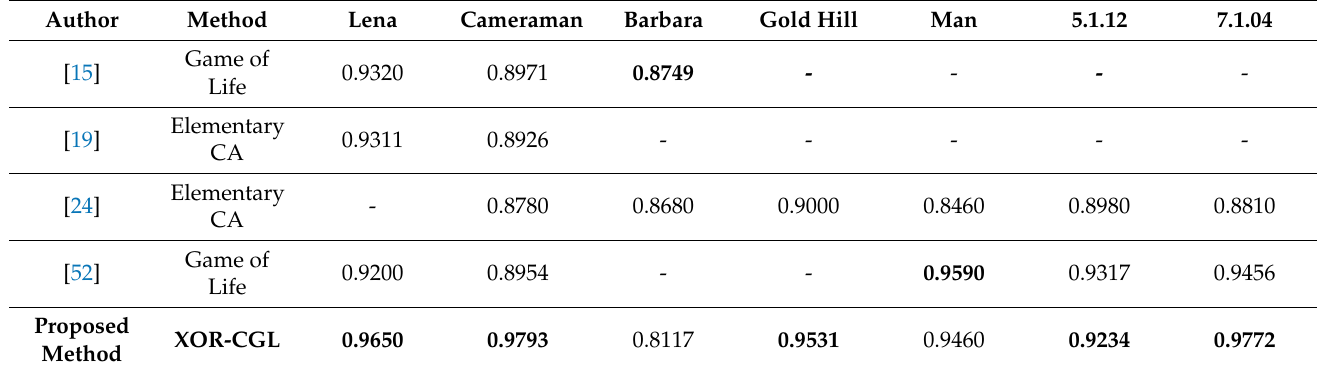
Table 7. Comparing different CA based scrambling techniques GDDs.